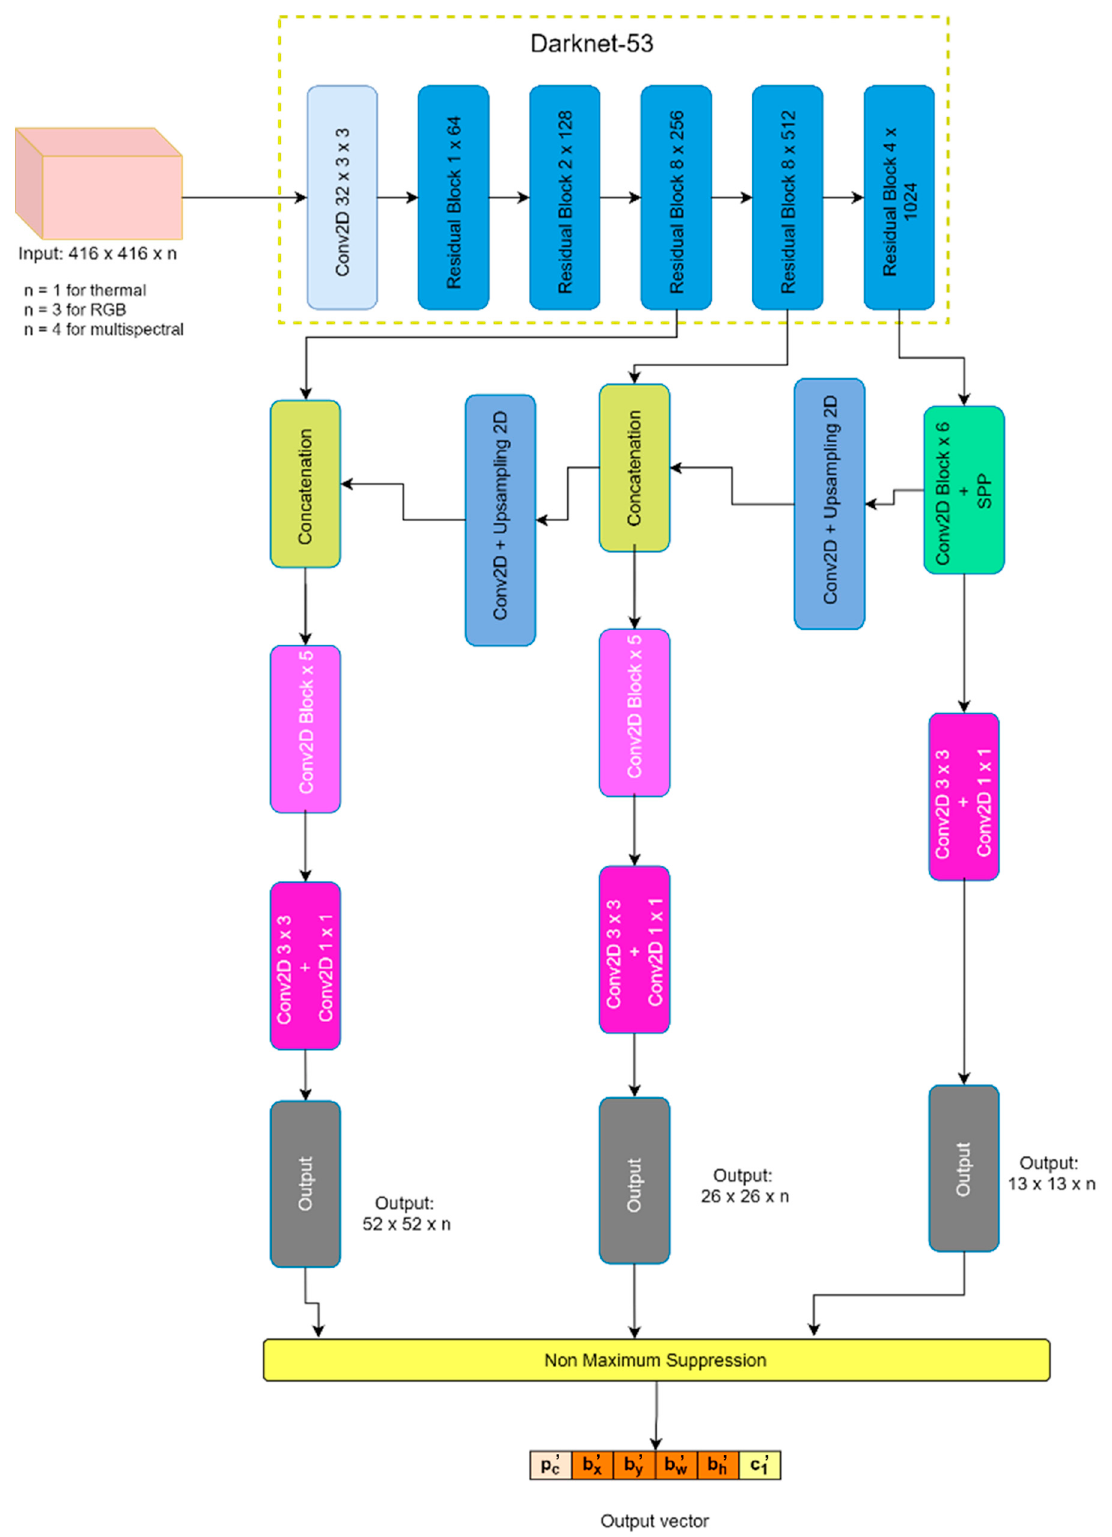
Figure 2. The system design of YOLO v3 with various image sources. The default input image size is 416 × 416 × n. n denotes the number of channels of the input image. Depending on the image sources, 1-channel is used for the thermal image, 3-channel is used for the RGB image, and 4-channel is used for the multispectral image. For all channels, all images are passed into the same architecture after the input. In the output vector, b (cid:48) x and b (cid:48) y indicate the centroid of the detected object, b (cid:48) w and b (cid:48) are the width and height of detected object, p (cid:48) c and c (cid:48) denote the probability of object existence and what class this detected object corresponds to.